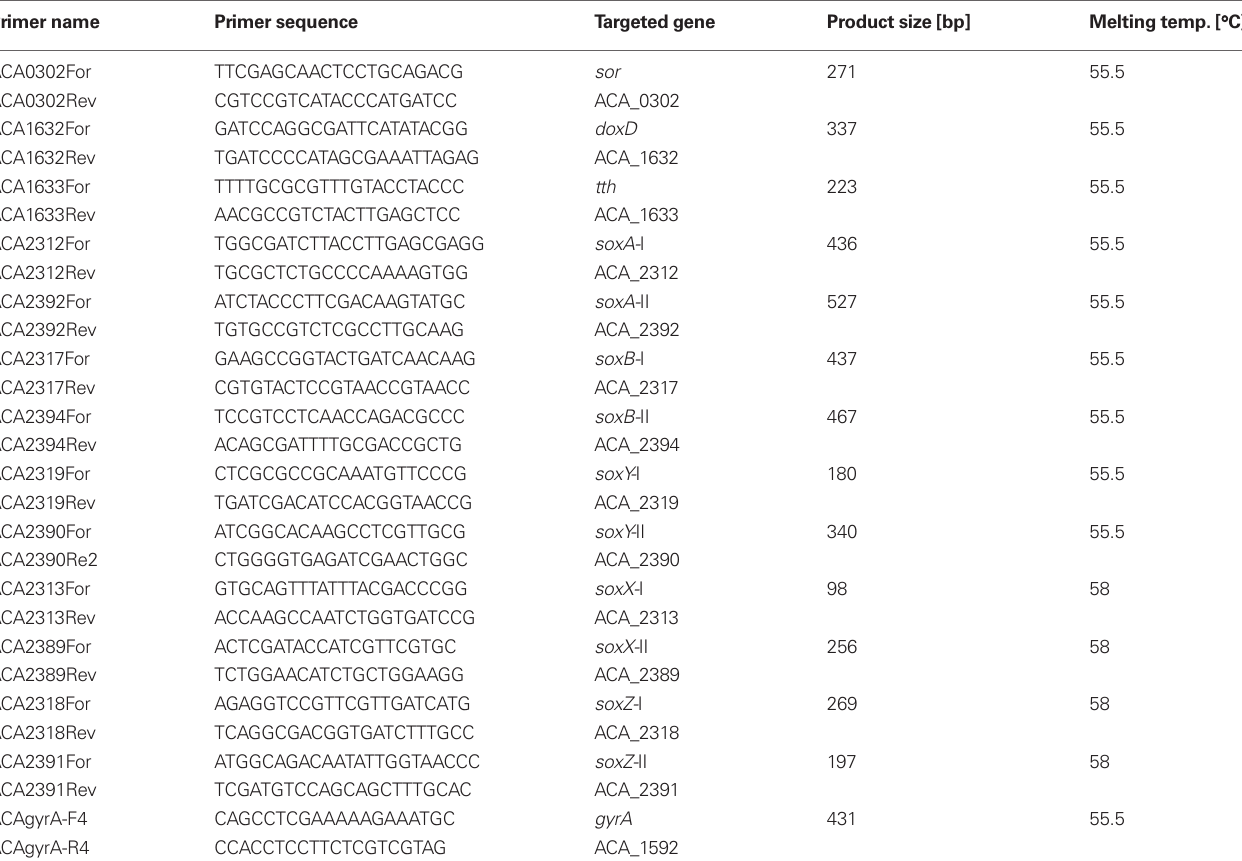
Table 1 | Primers used for RNA transcript